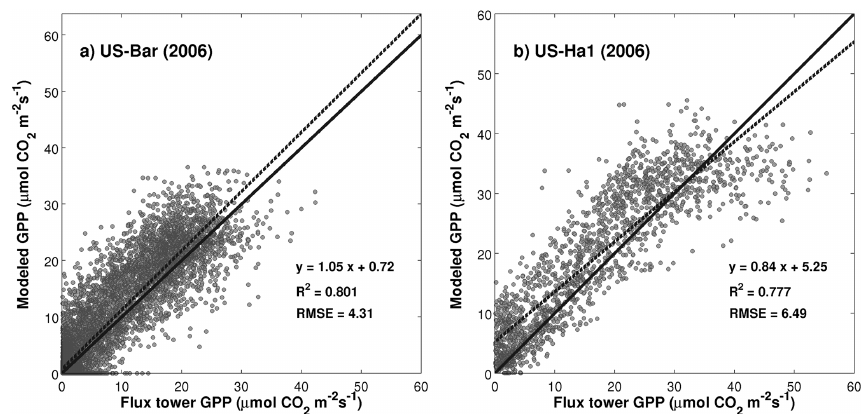
Figure 11. Regressions between modeled and measured GPP for all available hourly data at the sites of (a) US-Bar and (b) US-Ha1 in 2006. Only data from the photosynthetically active period are included in the regression. The solid lines denote the 1 : 1 line, and the dashed lines denote the regression